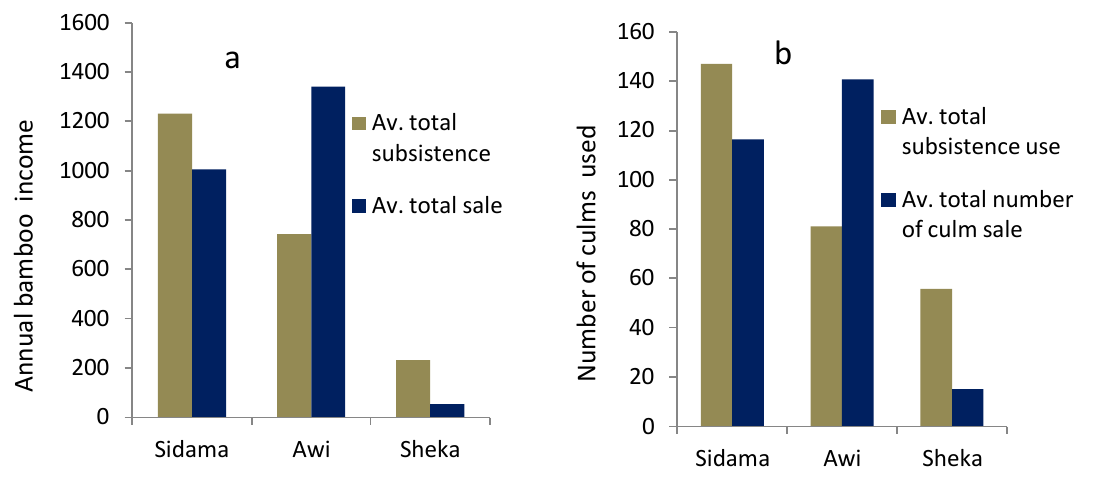
Figure 2. ( a ) Average total cash and subsistence income in birr; and ( b ) number of culms used for subsistence and sale, disaggregated by